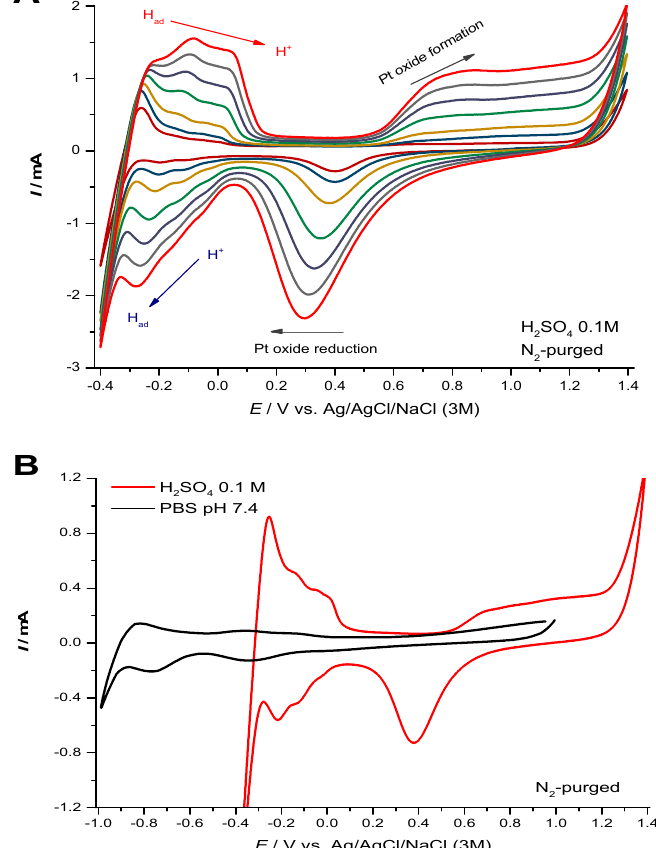
Figure 4. Electrochemical behavior in acidic and neutral electrolyte media. ( A ) Successive cyclic voltammograms (25 th scan) at increasing scan rates (50 − 1000 mV s − 1 ) obtained in N 2 saturated 0.1 M H 2 SO 4 , detailing the typical Pt oxide formation and reduction, proton adsorption (2 peaks) and desorption (3 peaks), and double layer zones. ( B ) Comparative CV plots (0.2 V s − 1 ) recorded in N 2 ‐ saturated 0.05 M, pH 7.4 PBS (black line) and N 2 ‐ saturated 0.1 M, H 2 SO 4 (red line) highlighting the positive shift in hydrogen evolution potential and increasing currents for Pt ‐ oxide formation and reduction at lower pH on the Pt surface of the Integra Probe recording site.